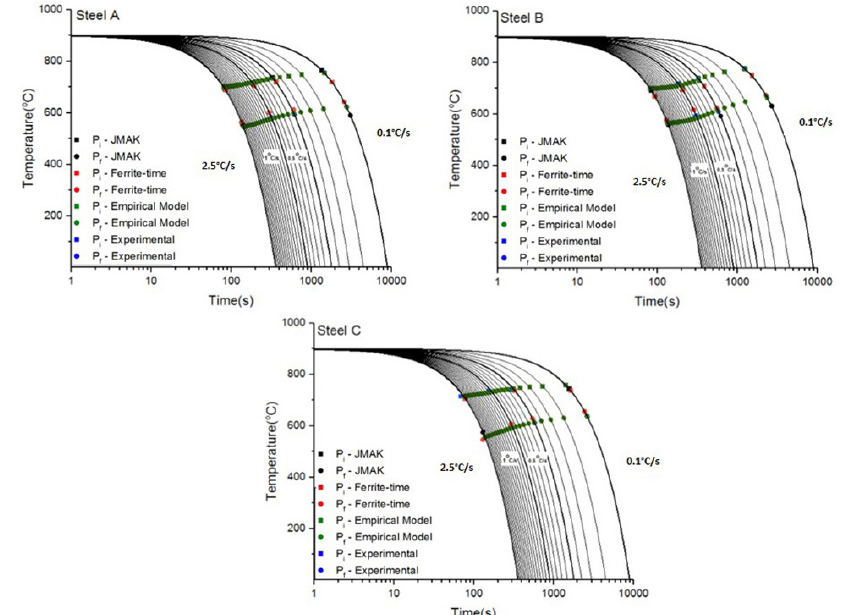
Figure 12. Calculated and experimental CCT diagrams of steels A, B and